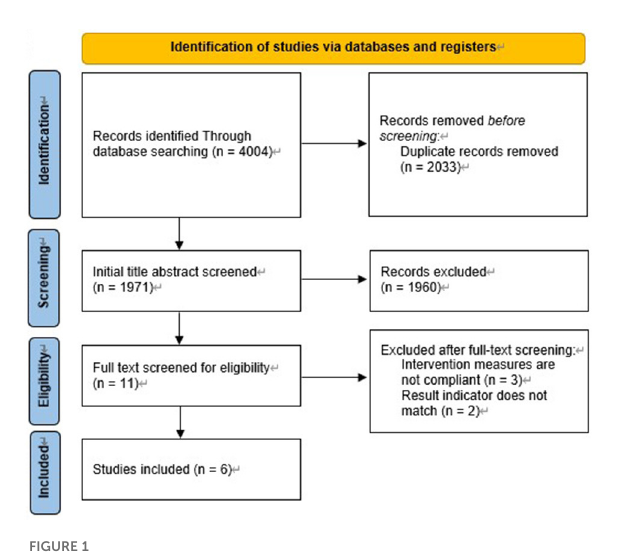
FIGURE1 Flowchart of the database search and study